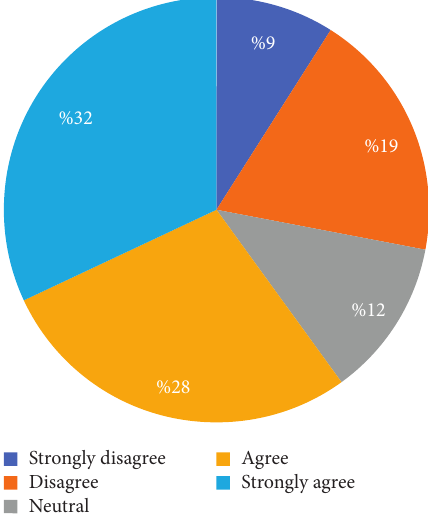
Figure 8: Q6: I think applying open data in Kuwait will need large support and